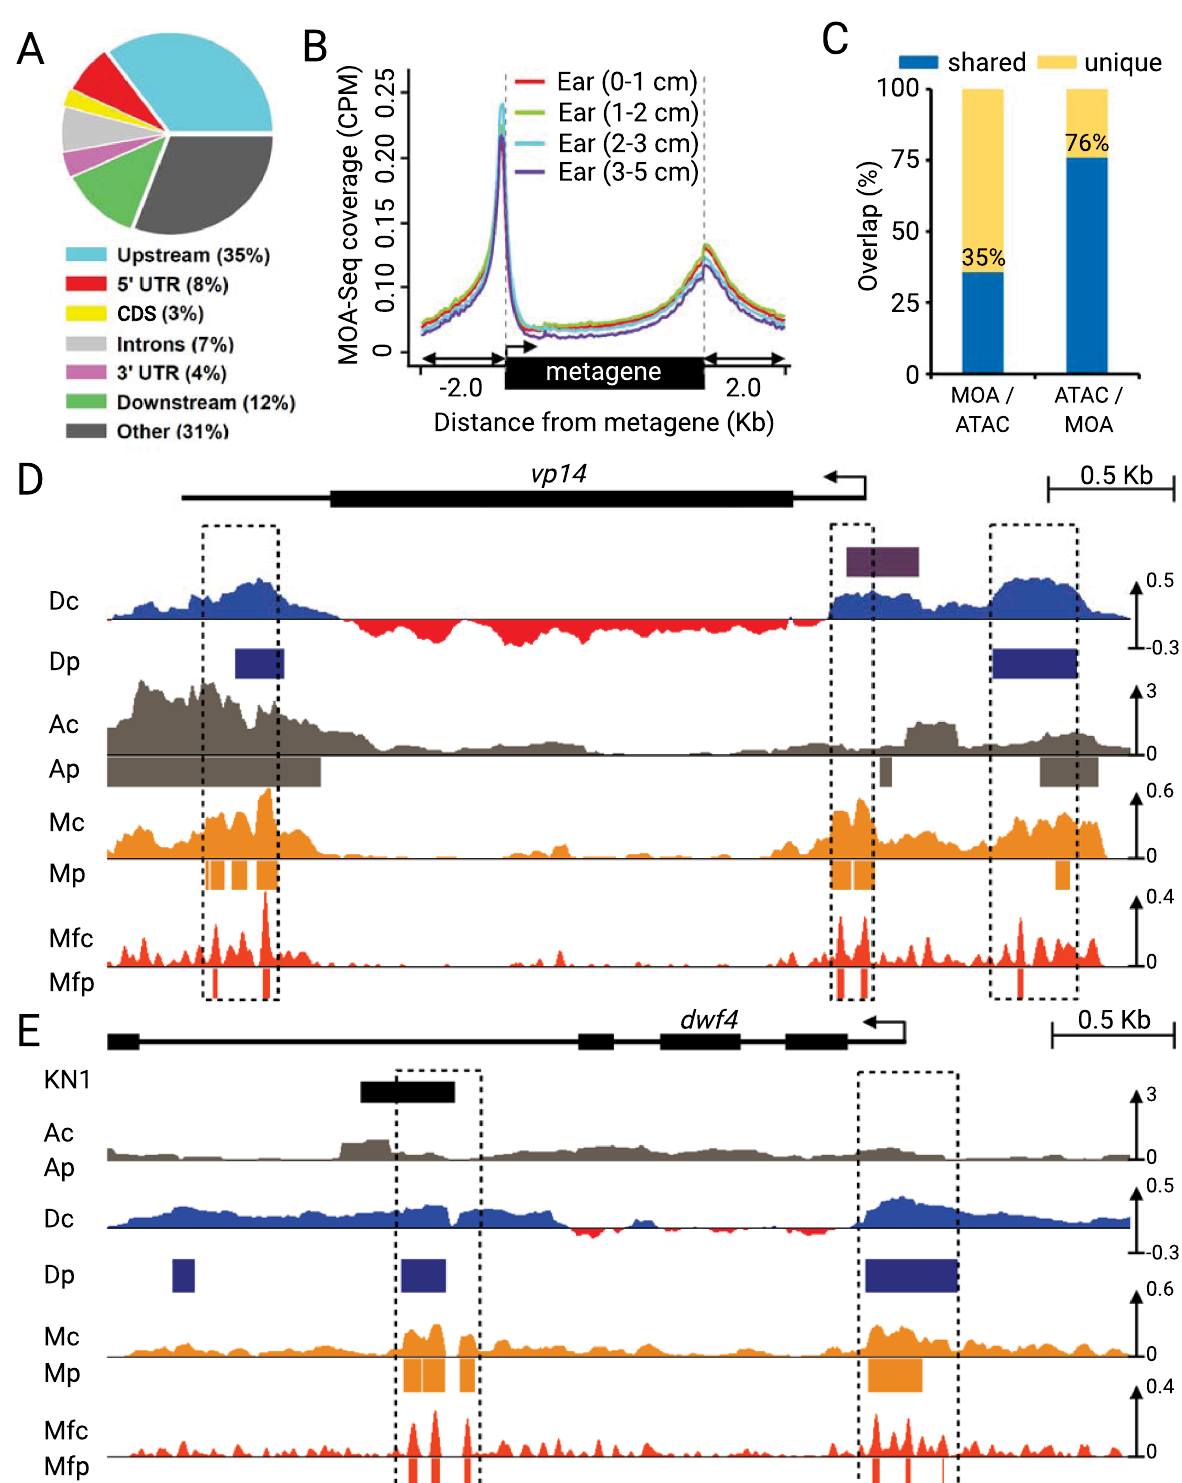
Fig 3. MOA-seq identifies shared and unique regions in open chromatin. Comparison of MOA-seq to open chromatin profiling techniques DNS-Seq and ATAC-Seq. (A) Genome-wide distribution of MOA-seq footprints relative to genomic annotations. (B) MOA-seq read coverage (CPM) is